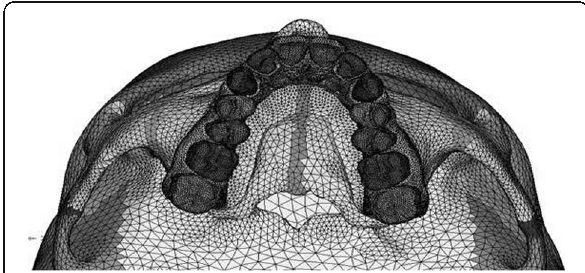
Fig. 5 Palatal view of the three-dimensional FE